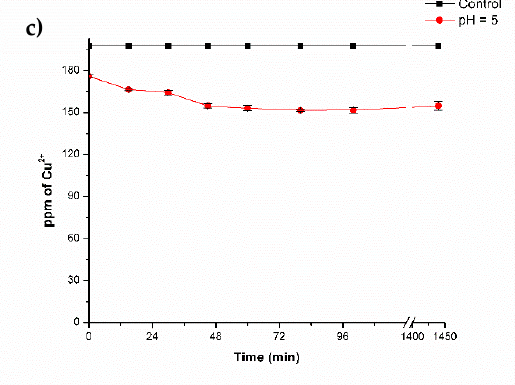
Figure 4. Biosorption of copper with lyophilized composite beads at pH 5 and 35 °C: ( a ) 50 ppm; ( b ) 100 ppm, and ( c ) 200 ppm of Cu 2+ .